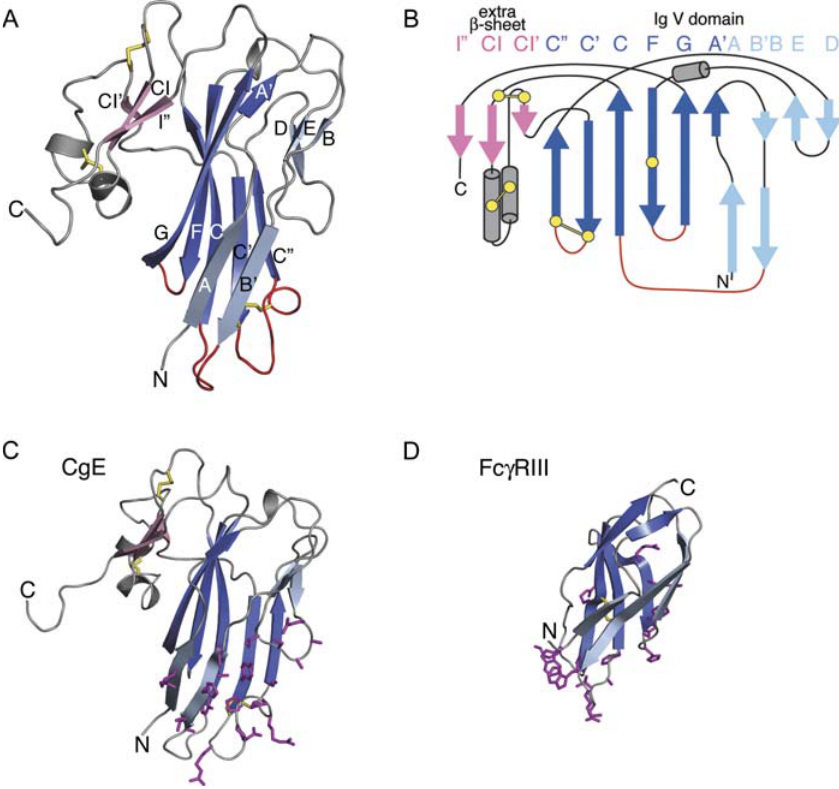
Figure 2. Structure of CgE (A) Ribbon diagram of the CgE structure. b -strands D, E, B, B 9 , and A are light blue, strands A 9 ,G, F, C, C 9 , and C 99 are dark blue, strands CI 9 , CI, and I 99 are pink, a -helical regions are gray, disulfide bonds are yellow, and the three CDR loops (as defined in Ig V domain structures) are red. All figures depicting protein structures were generated with PyMOL (The PyMOL Molecular Graphics System, http://www.pymol.org). (B) CgE topology diagram. b -strands are shown as arrows (colored as in [A]), and helices are shown as gray cylinders. Cysteines are shown as yellow circles with disulfide bonds indicated by yellow lines between paired cysteines. (C) Ribbon diagram of CgE with Fc-binding residues highlighted. b -sheets are colored as in (A) (D E B B 9 A, light blue; A 9 G F C C 9 C 99 , dark blue; and CI 9 CI I 99 , pink), and side chains in the predicted Fc-binding interface (see text) are in magenta. Disulfide bonds are in yellow. (D) Ribbon diagram of Fc c RIII with Fc-binding residues highlighted. b -sheets for Fc c RIII (pdb entry 1e4j) are colored similar to (C) (E B A, light blue; and A 9 G F C C 9 , dark blue), and side chains in the Fc-binding interface [44] are in magenta. Disulfide bonds are in yellow. DOI: 10.1371/journal.pbio.0040148.g002